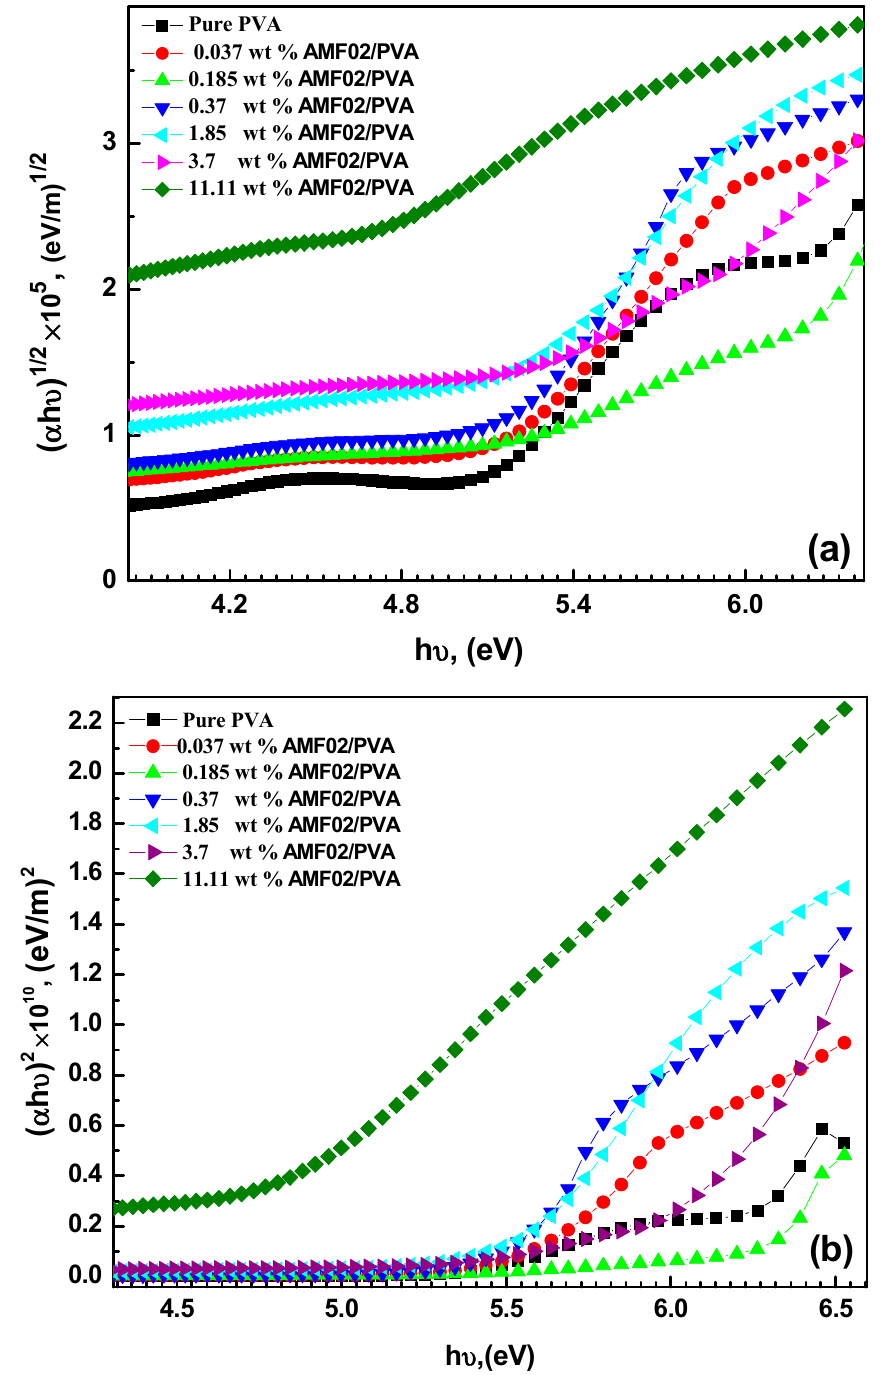
Figure 6. ( a ) The ( α h υ ) 1/2 , and ( b ) the ( α h υ ) 2 variations vs. photon energy ( h υ ) for AMF02/PVA novel PCCEFs.